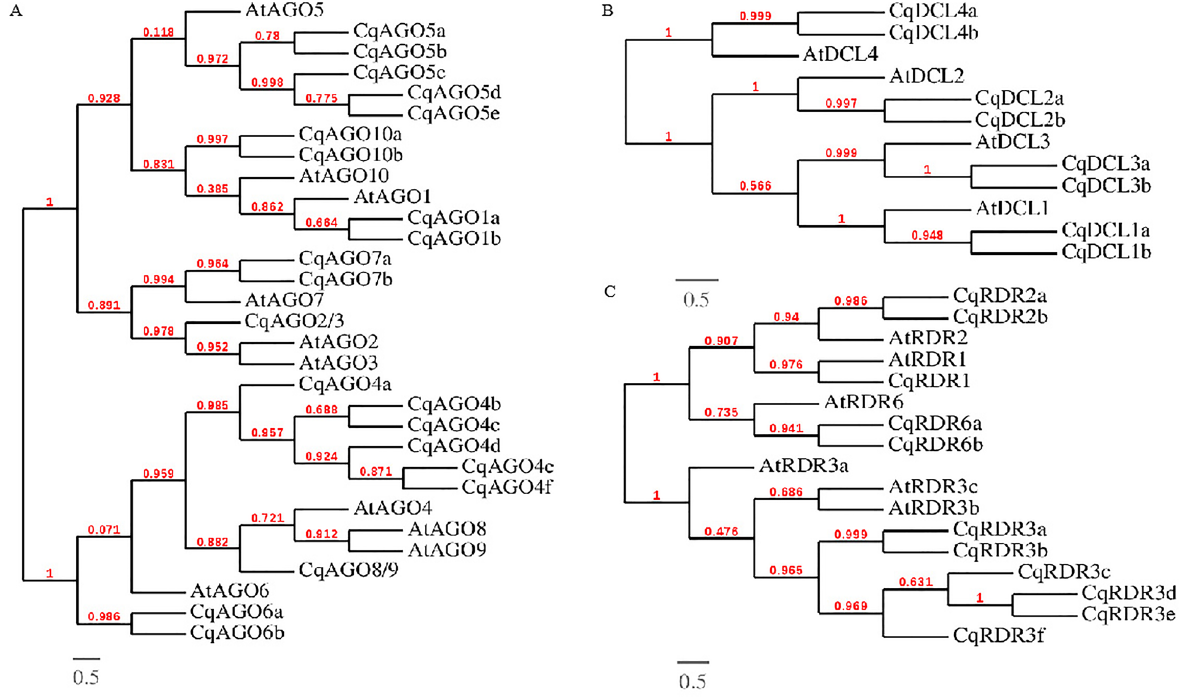
Figure 1. Phylogenetic analysis. ( A ) Relationship between AtAGO and CqAGO proteins. ( B ) Relationship between AtDCL and CqDCL proteins. ( C ) Relationship between AtRDR and CqRDR proteins. Branch length was ignored, and branch support values are displayed. The scale bar at the bottom left corner represents the branch length.